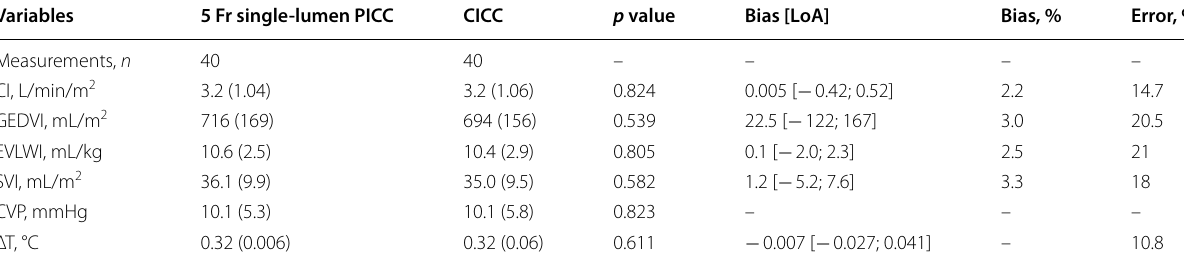
Data are reported as mean (standard